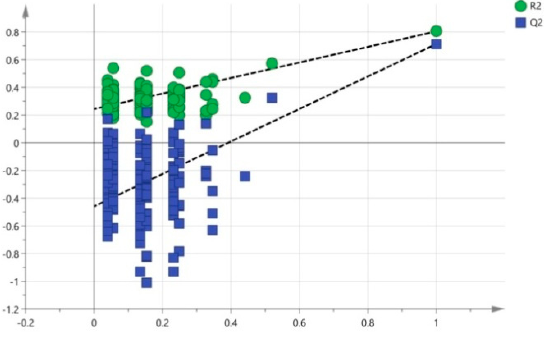
Figure 8. The 200-time permutation tests for the PCA and OPLS-DA models.